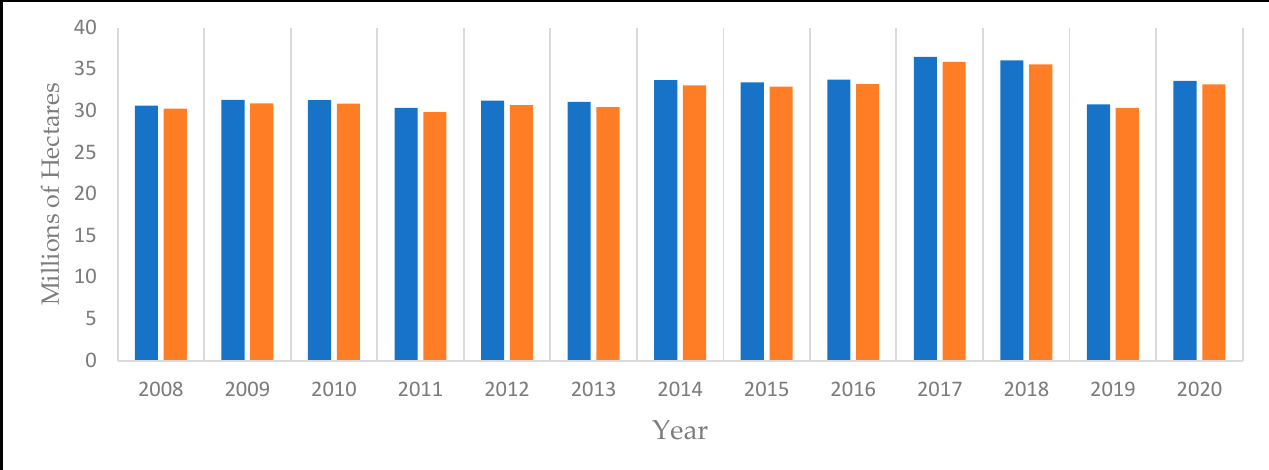
Figure 3. Total Soybean Hectares planted in the USA from USDA NASS and USDA FSA. Because the data are compiled directly from a very large percentage of growers, the FSA crop area data are, most likely, the most complete, granular dataset for crop planting area in the USA. Comparison of changes in crop area in a county from year to year may